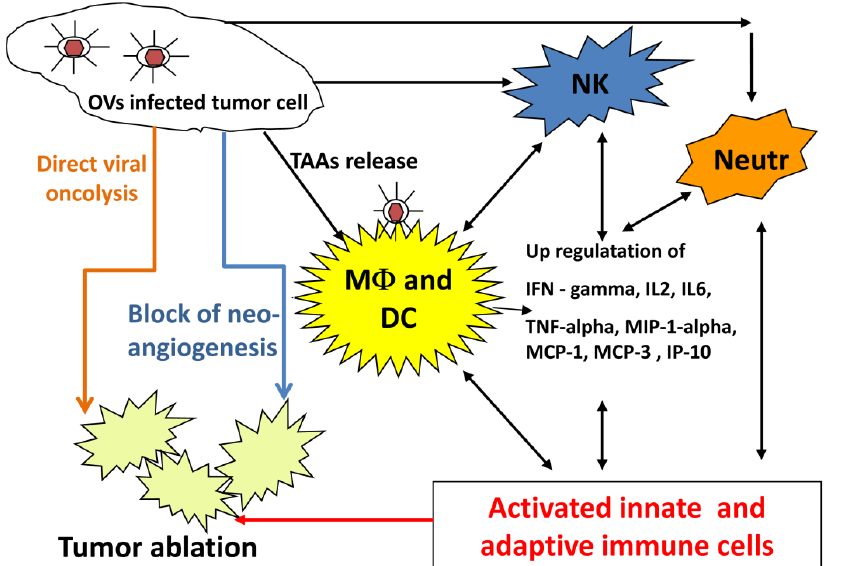
Figure 1. Possible mechanisms of oncolytic virus mediated tumor